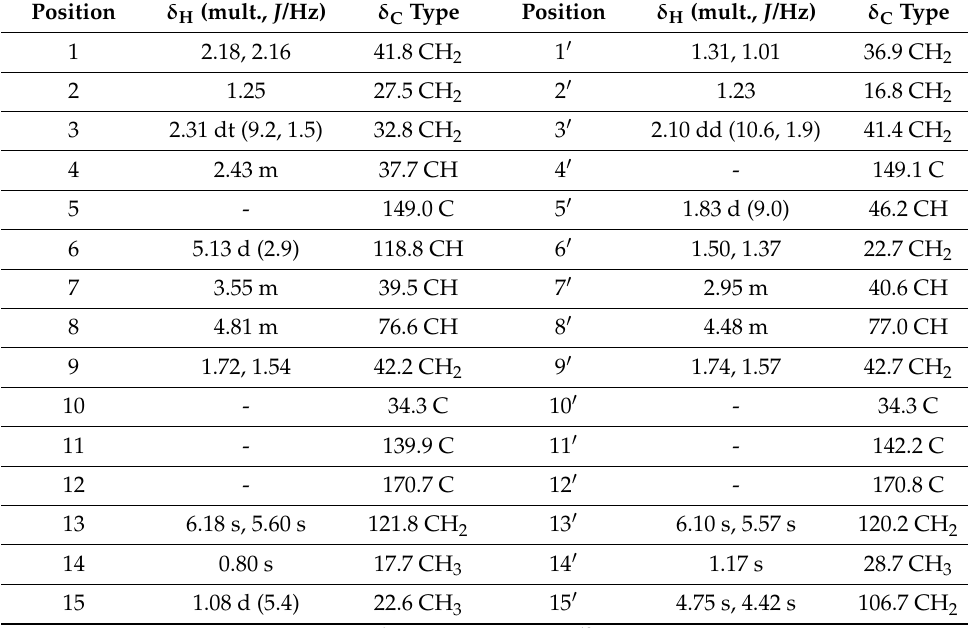
Table 1. 1 H and 13 C NMR spectroscopic data of compound 1